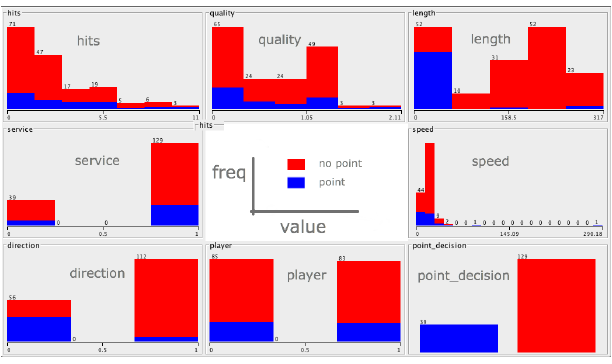
Figure 8. Attribute visualisation for 178